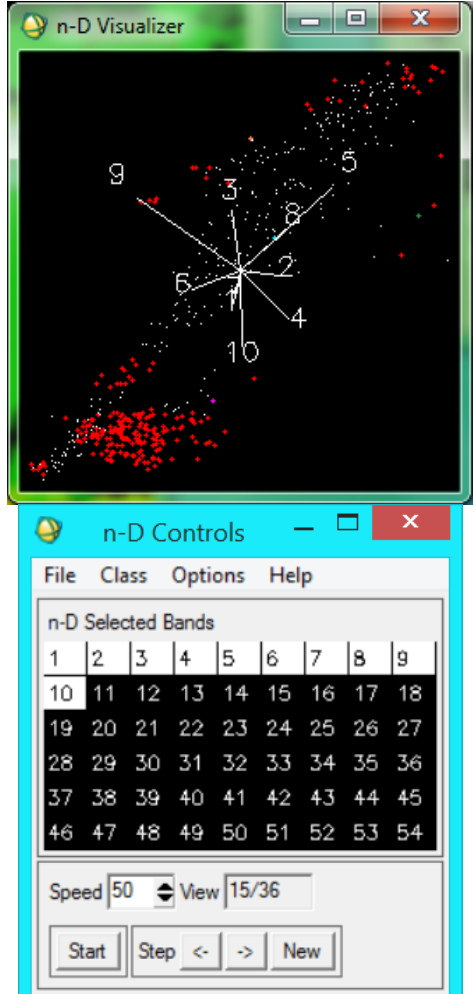
Fig.10. Display of the clustering of purest pixels in the n D- visualiser.